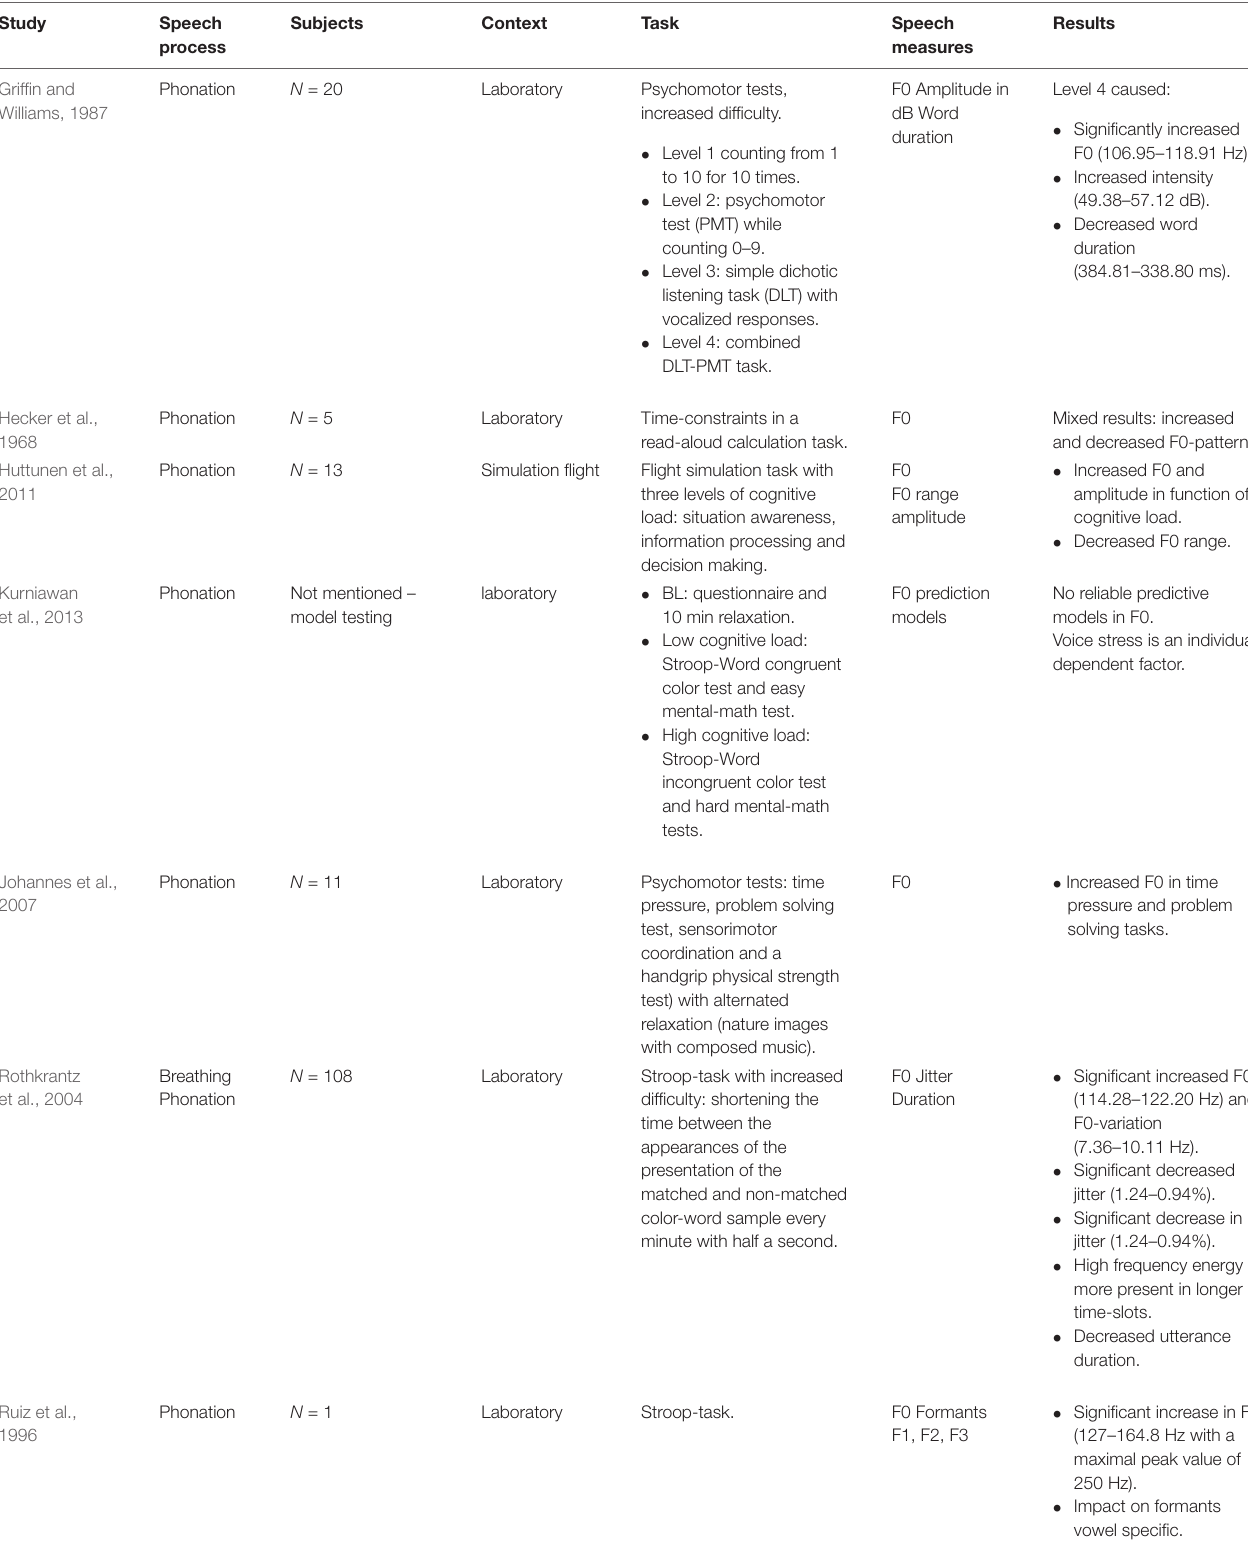
TABLE 6 | Studies on the impact of cognitive load on voice and speech